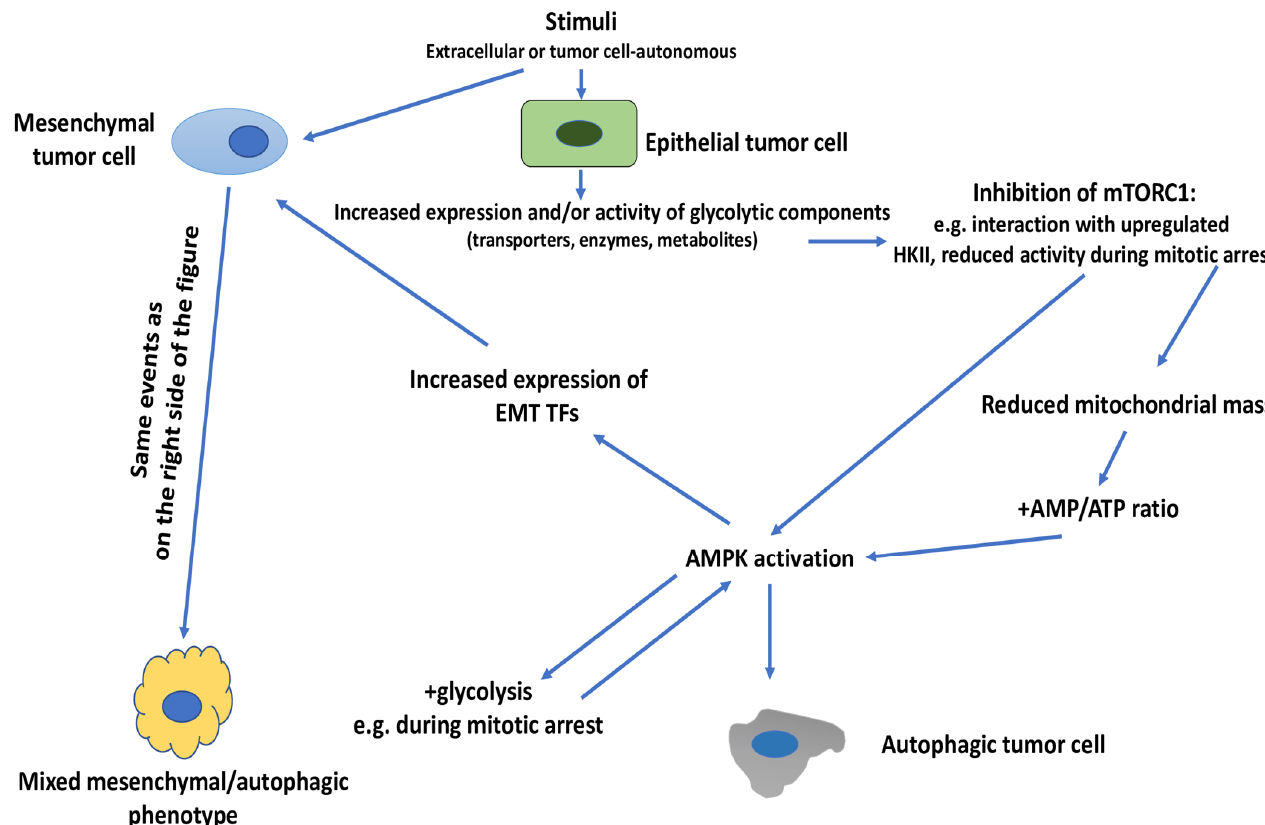
Figure 5. Glycolysis-induced autophagy or mixed, mesenchymal/autophagic phenotype in the presence of glucose sufficiency. Stimuli, either tumor cell-autonomous or from the TME (extracellular) increase the expression and/or activity of one or more glycolytic components (transporters, enzymes or metabolites). At least one glycolytic component (HKII) has been shown to interact with mTOR and inhibit mTORC1. Inhibition of mTORC1 may also occur during mitotic arrest. This inhibition then leads to AMPK activation and autophagy induction. Prolonged mitotic arrest may also promote AMPK-driven upregulation of glycolysis which, through mechanisms similar to those described before (e.g., upregulation of HKII), may lead to AMPK activation and autophagy induction. When these events are induced in epithelial tumor cells, they give rise to an autophagic tumor cell. When they are induced in a tumor cell that has already acquired mesenchymal traits, then they are expected to give rise to a mixed, mesenchymal/autophagic phenotype. AMPK, adenosine monophosphate-activated protein kinase; ATP, adenosine triphosphate; EMT, epithelial–mesenchymal transition; HKII, hexokinase II; mTOR, mechanistic target of rapamycin; mTORC1, mTOR complex 1; TF, transcription factor.